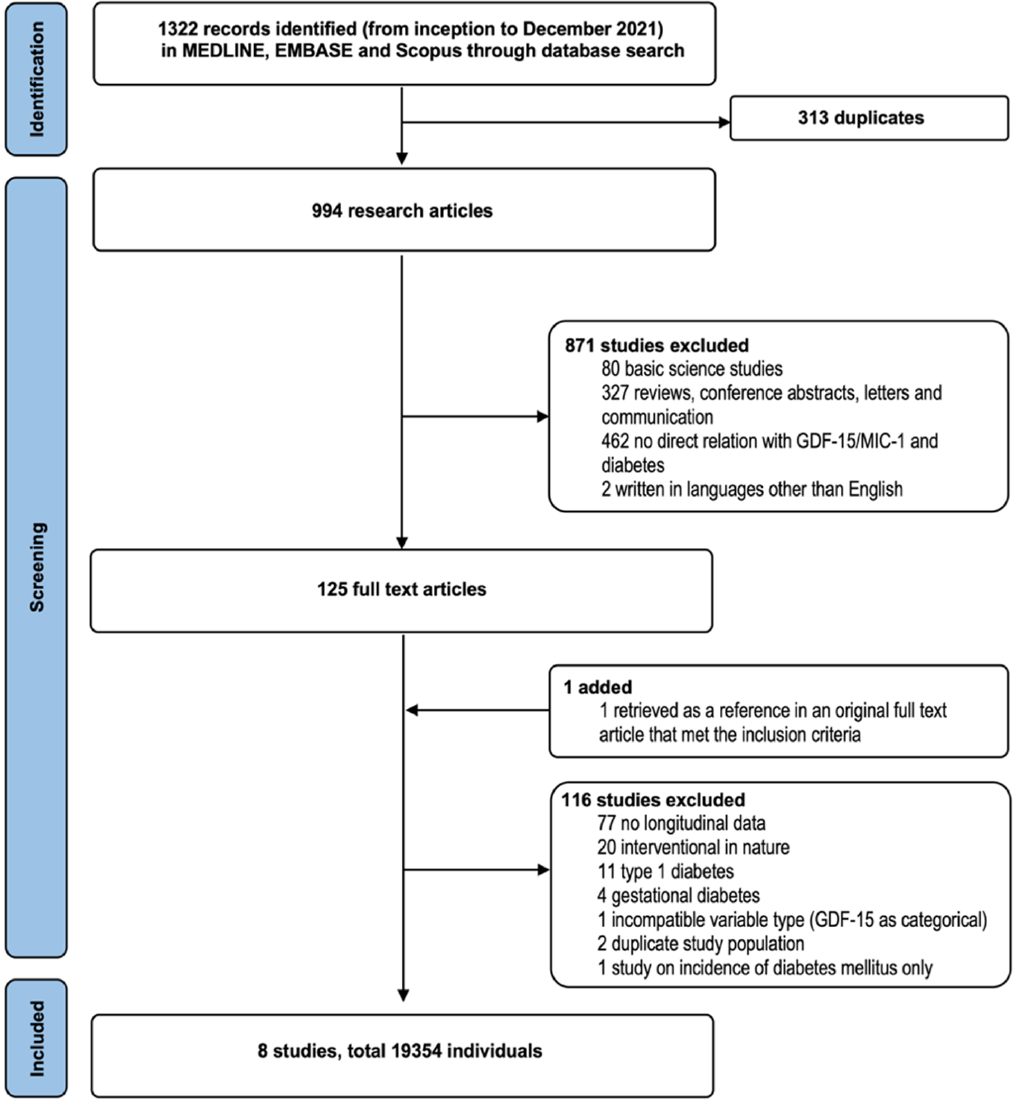
Figure 1. PRISMA flow diagram showing the literature search and article selection